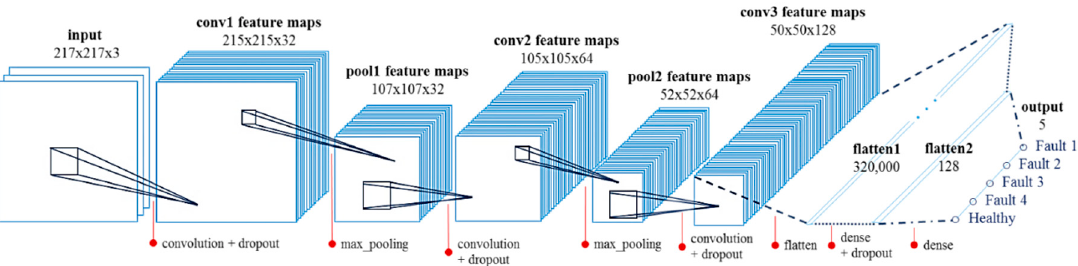
Figure 7. A proposed convolutional neural network (CNN) architecture with actual parameters.